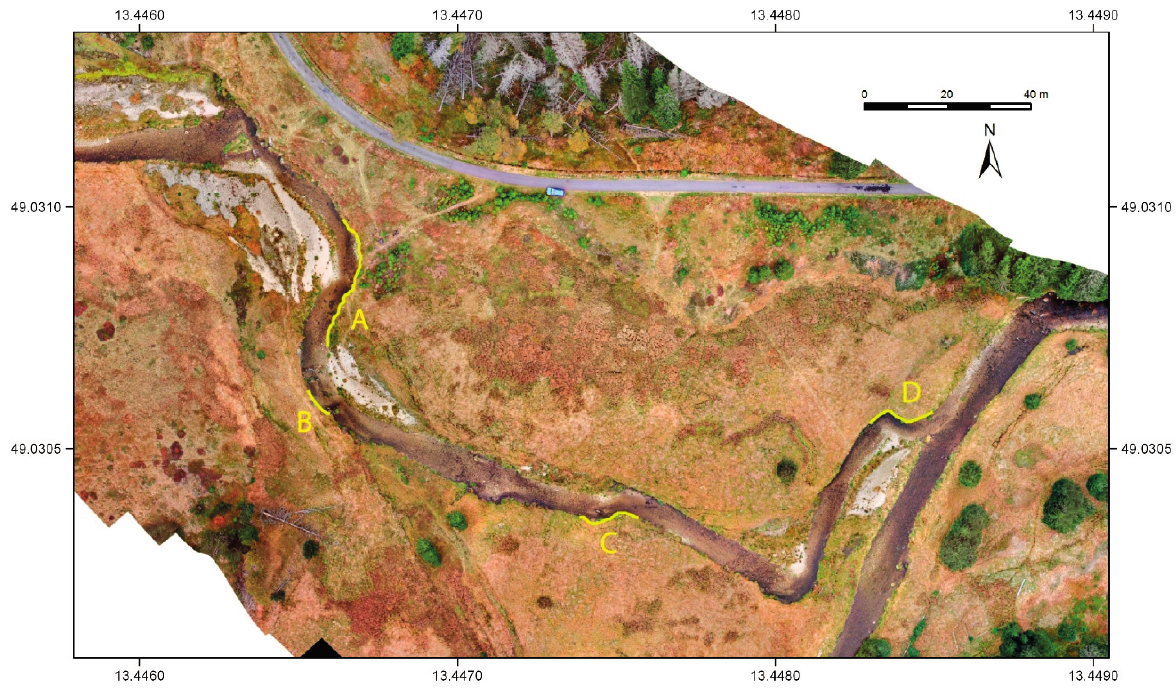
Figure 8. Orthomosaic and lateral erosion of Javo ř í brook with identification of spots of the lateral